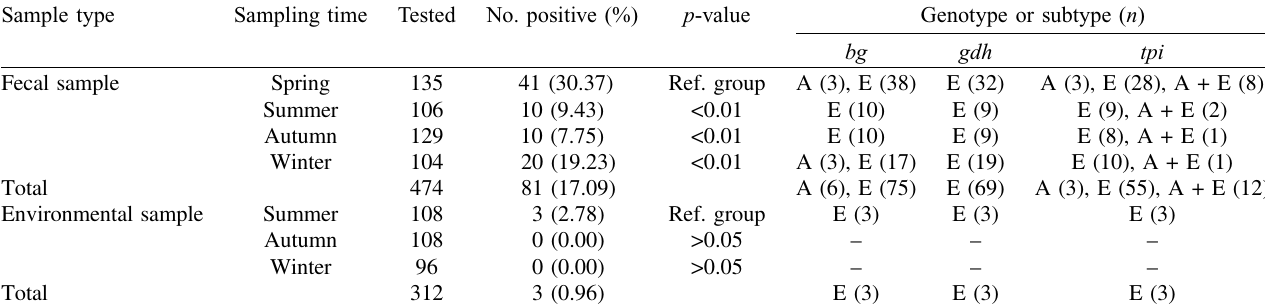
Table 1. Prevalence of G. duodenalis in Hu sheep and rates of positive environmental samples from different seasons.